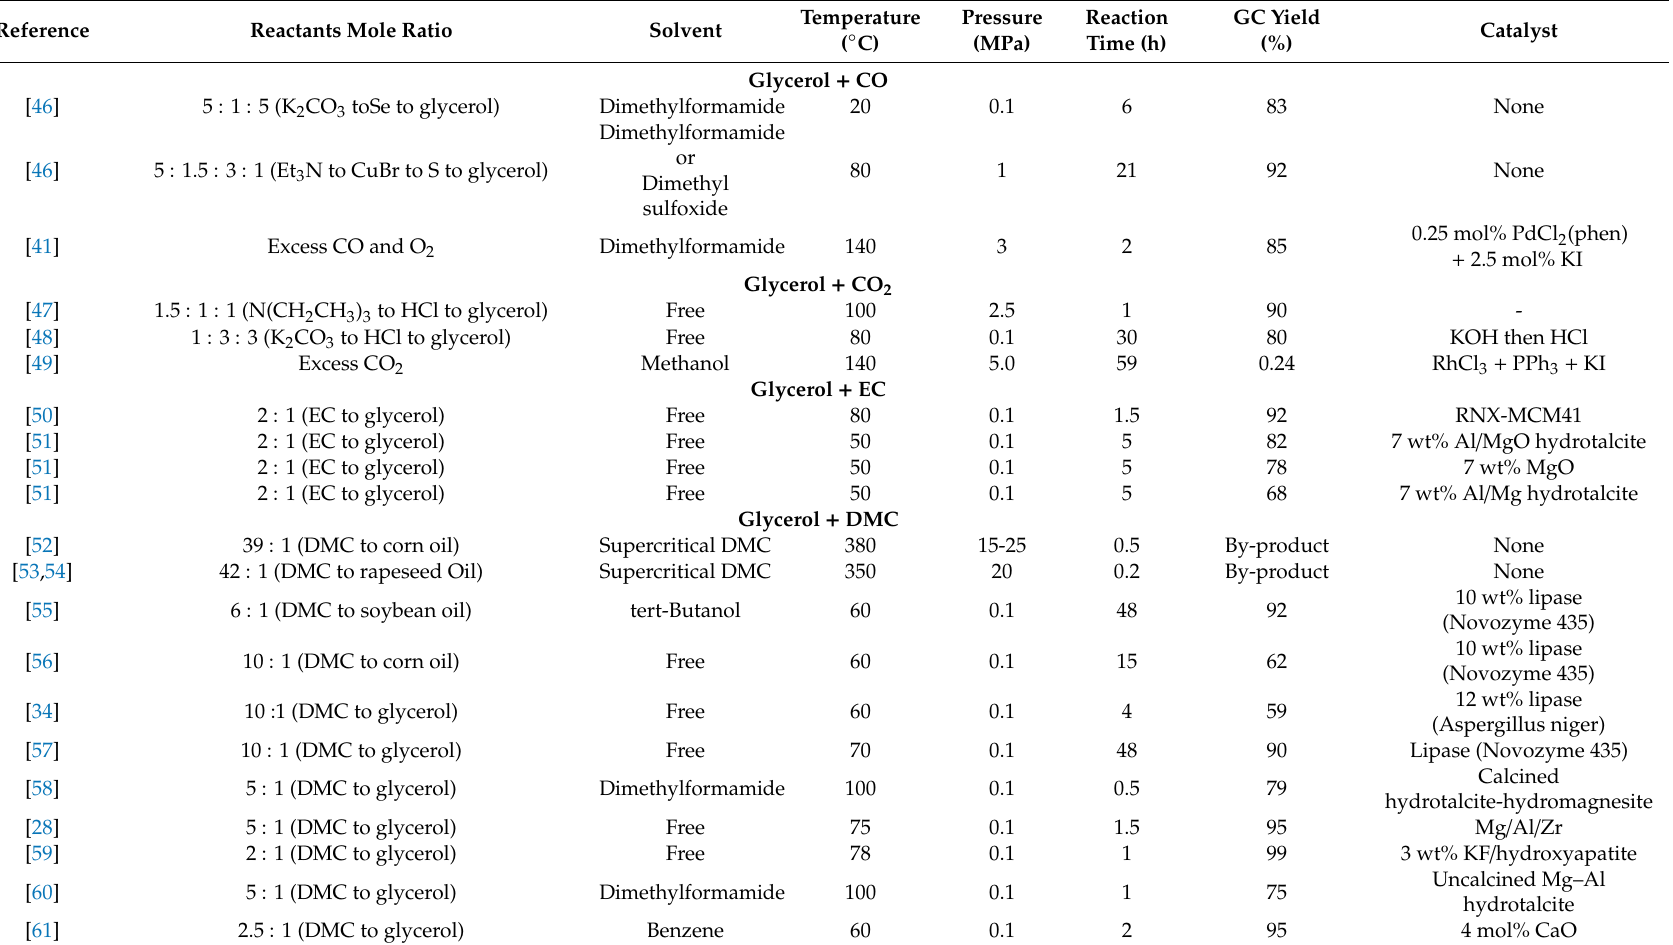
Table 4. Di ff erent routes for the synthesis of glycerol carbonate (Gly-C) and their experimental